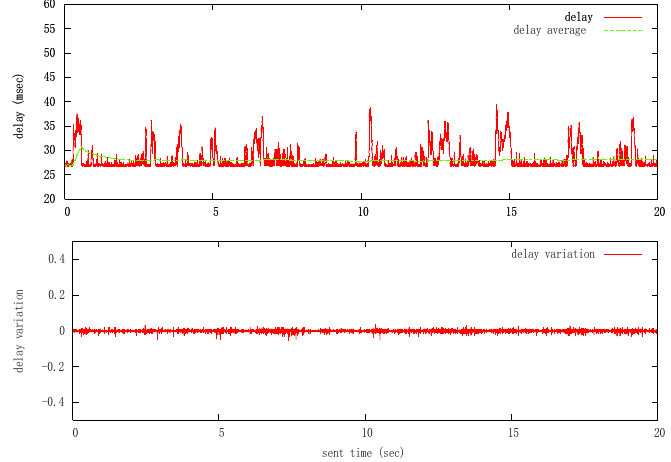
Figure 19. Experimental delay bounds between Vigo and Manchester. ( Top ) Magnitude; ( Bottom ) Variation.